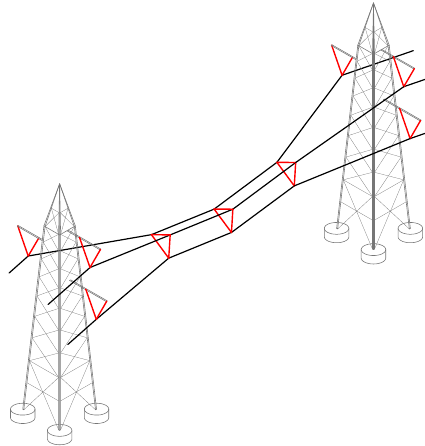
Figure 1. Synthetic representation of a general 3-phase line with three compactors along the span (depicted in red).